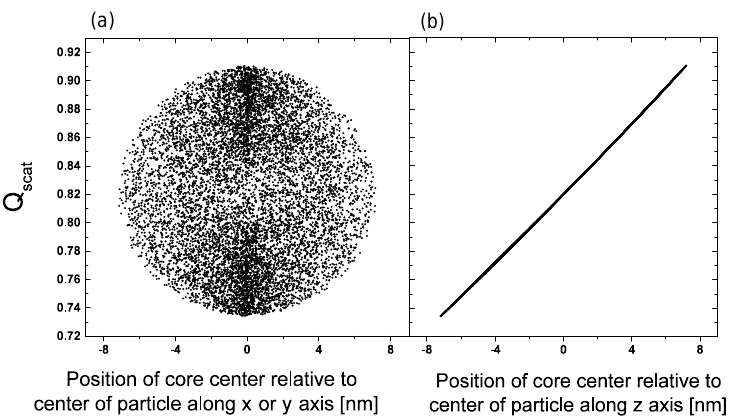
Figure 3. The change in Q scat with the relative position of the core ( r core = 92 . 8nm) to the particle center perpendicular to the direction of light, x and y axis (a) and along the direction of light, z axis (b) for particle with OIR = 1 : 4, k = 0 . 168, r particle = 100nm over 10000 realizations.